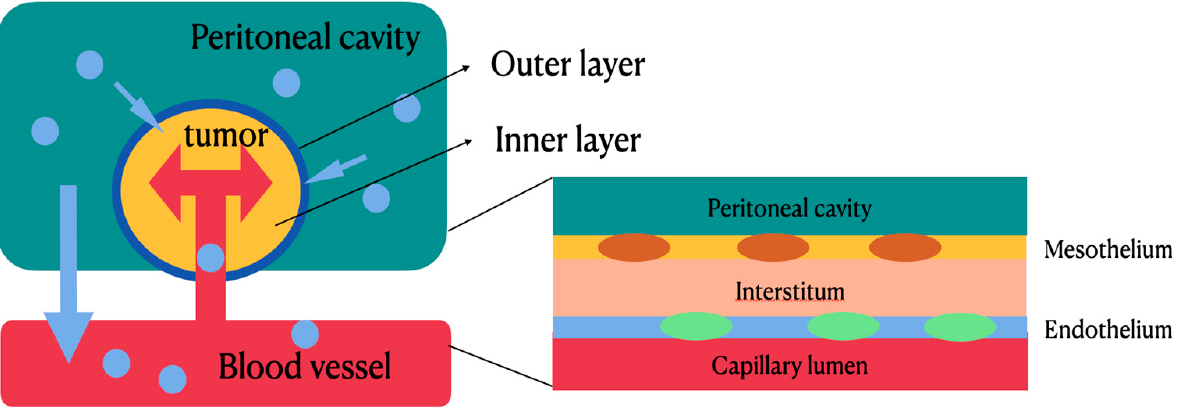
Figure 2. Bidirectional models for intravenous and intraperitoneal therapy. The outer layer of the tumor can achieve a high concentration of drug levels by direct exposure, while the drug can reach the inner core layer of the tumor by microcirculation through systemic circulation. Between the two compartments is the peritoneal–plasma barrier, which can decrease drug clearance rate from peritoneal cavity to systemic circulation.